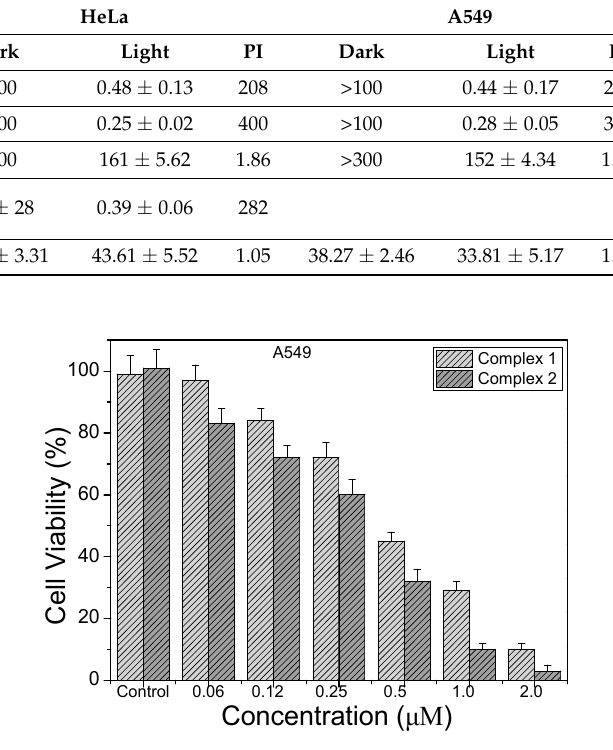
Figure 8. Cell viabilities of A549 cells pretreated with various concentrations of complexes 1 and 2 for 12 h and irradiated at 450 nm, for 10 min (6 mW/cm 2 ).